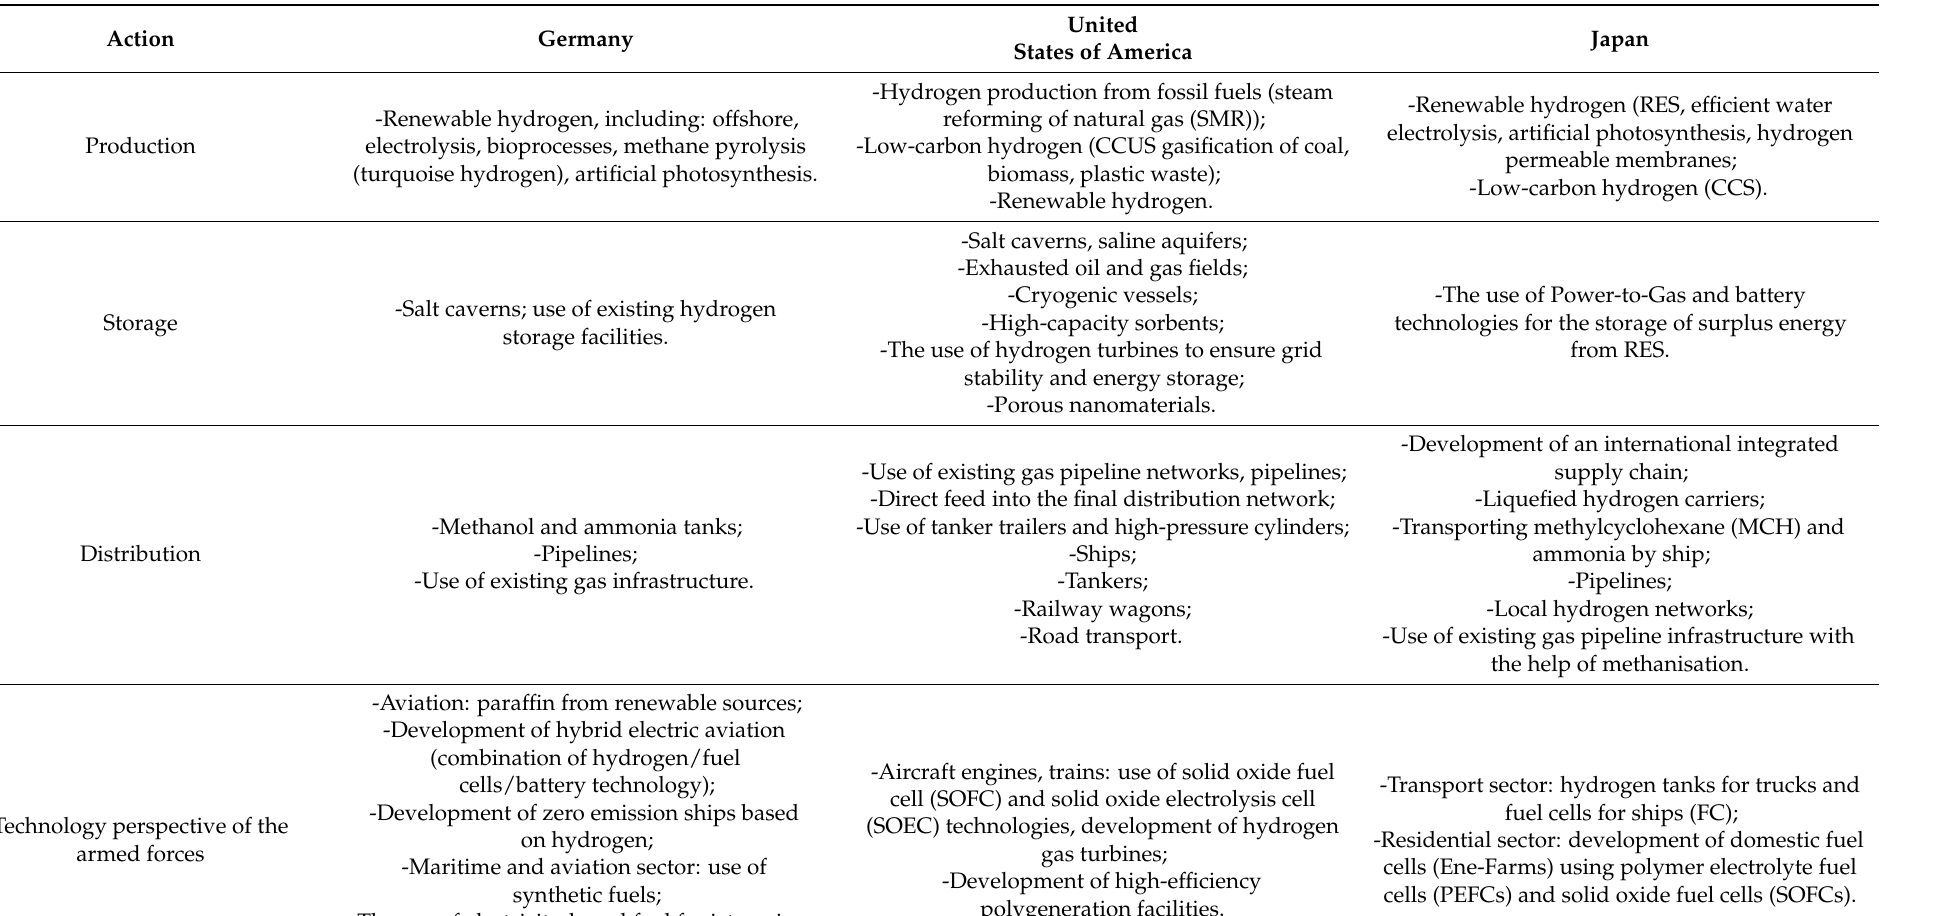
Table 1. Key elements of the hydrogen strategies of Germany, the United States, and